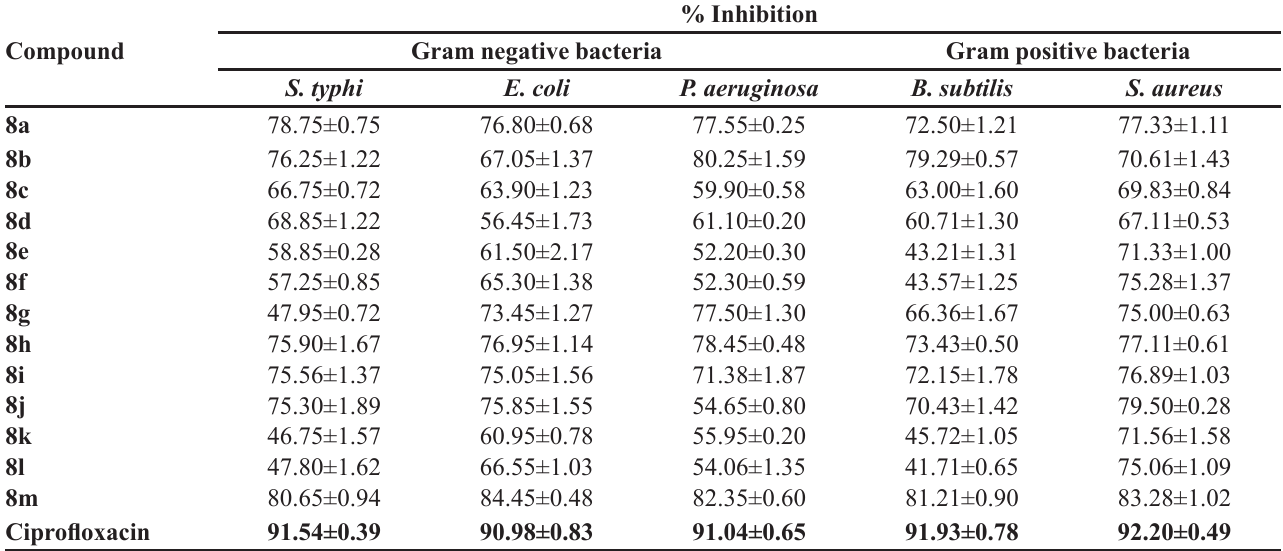
TABLE II - The % inhibition of antimicrobial activity of the synthesized compounds